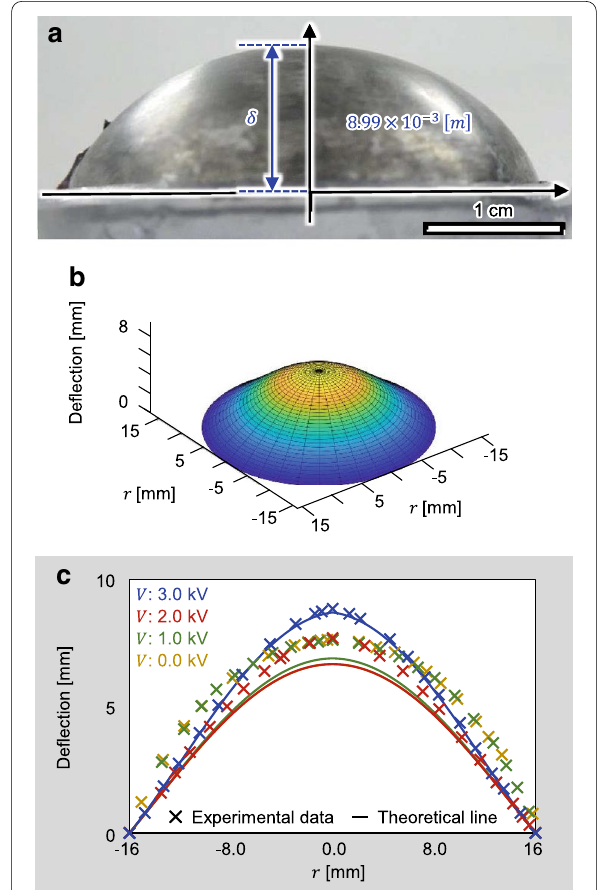
Fig. 6 Evaluation of DEA with water pressure and electric voltage. a Experimental picture of DEA with a pressure of 1.37 kPa and electric voltage 3.0 kV. b Theoretical data with the same conditions as the experiments in a . c Comparison of experimental and theoretical data with changing voltage